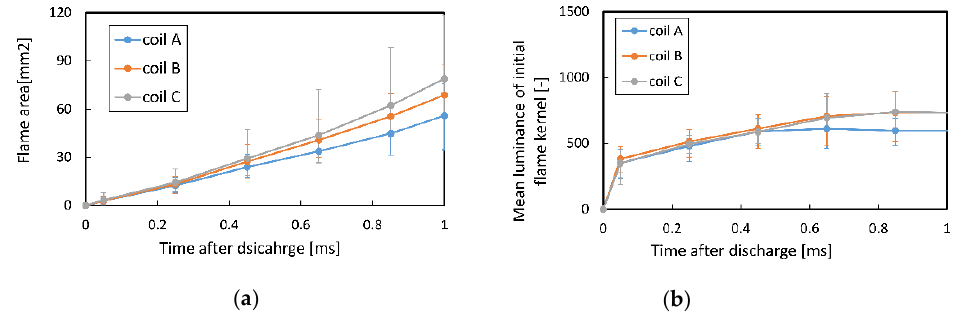
Figure 14. High flow condition: ( a ) Initial flame area; ( b ) Initial flame luminance.